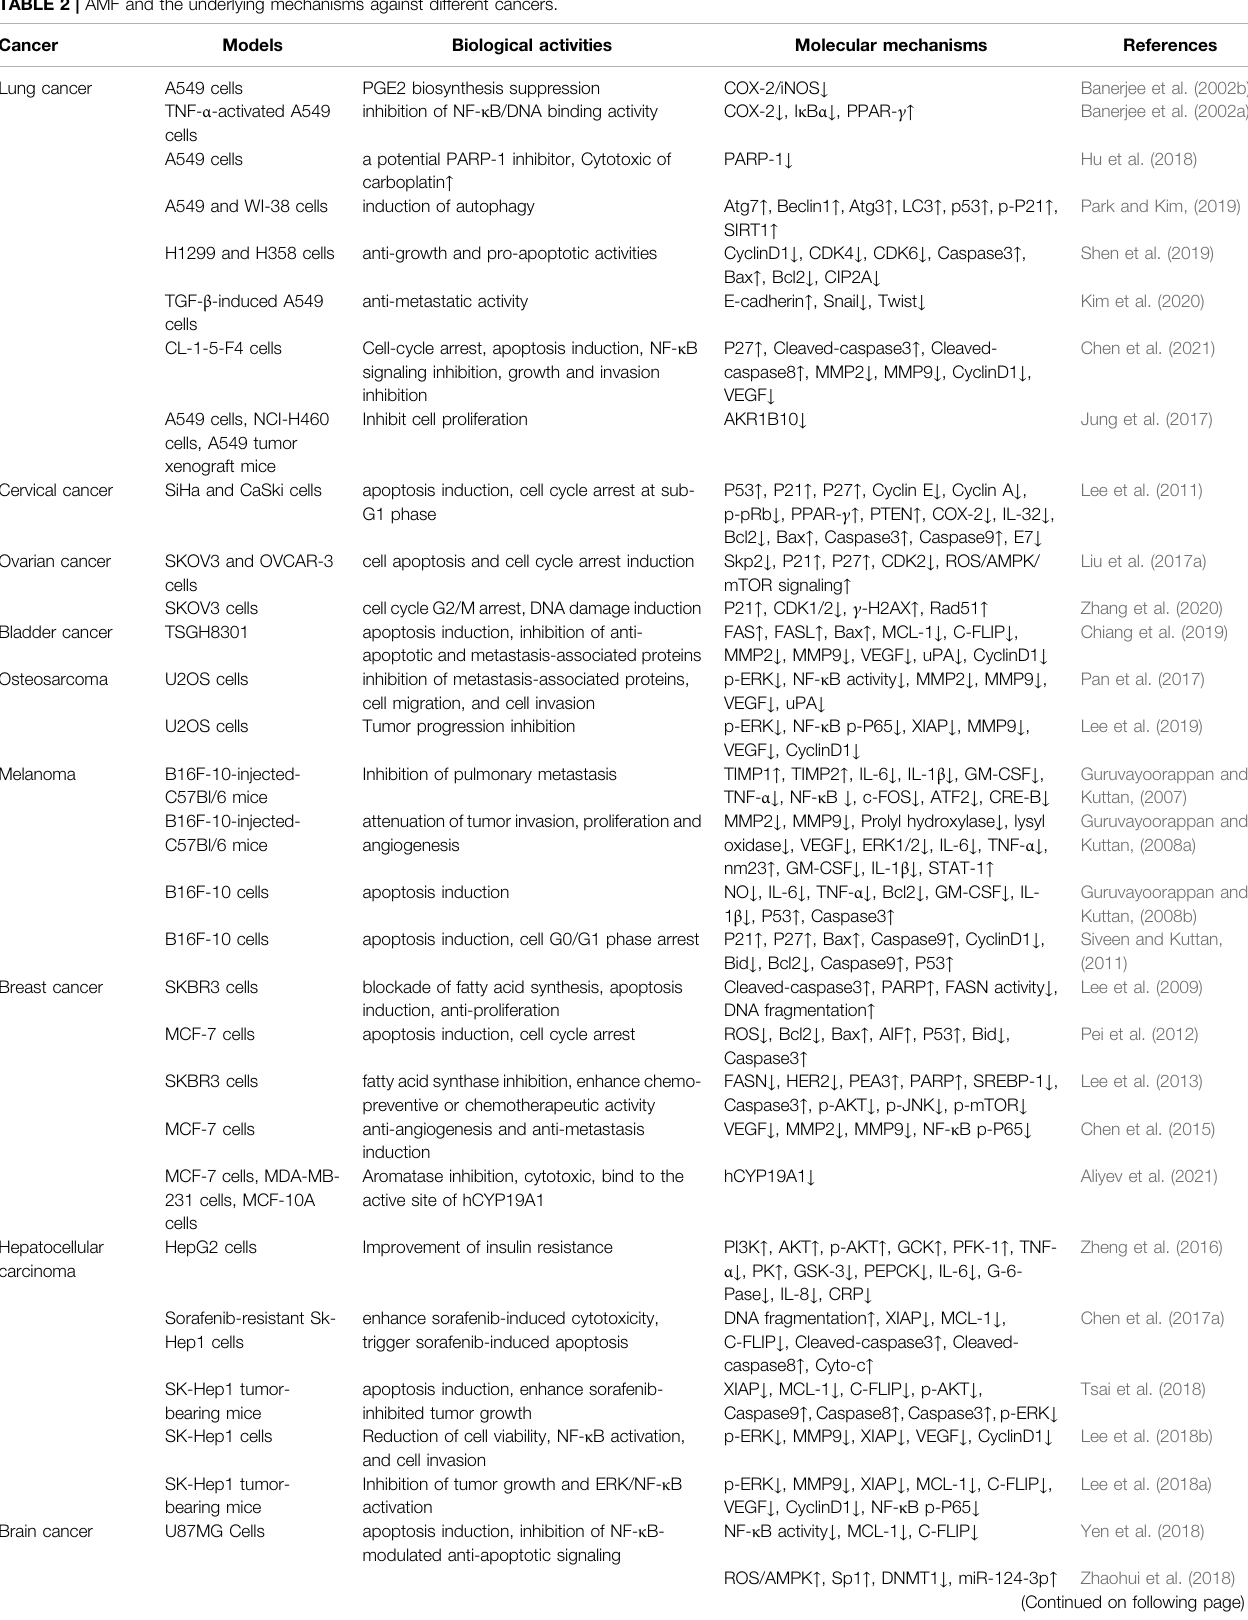
TABLE 2 | AMF and the underlying mechanisms against different cancers.